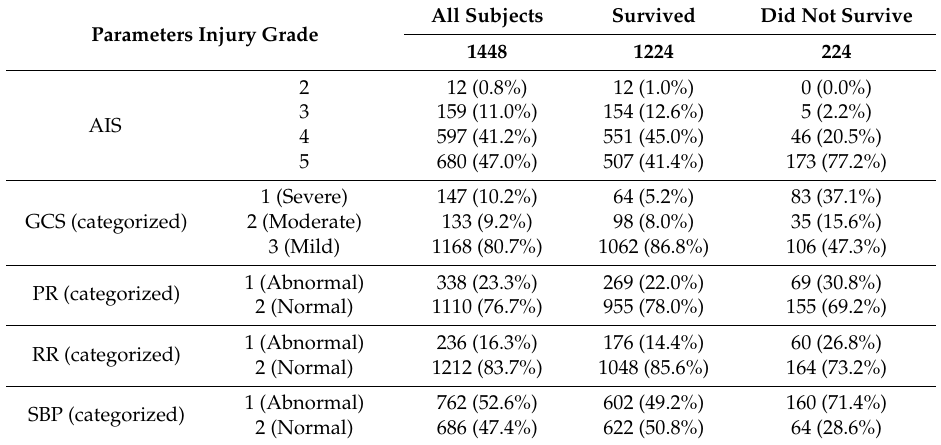
Table 9. Analysis of injury parameters in relation to cases that survived and those that had not survived.